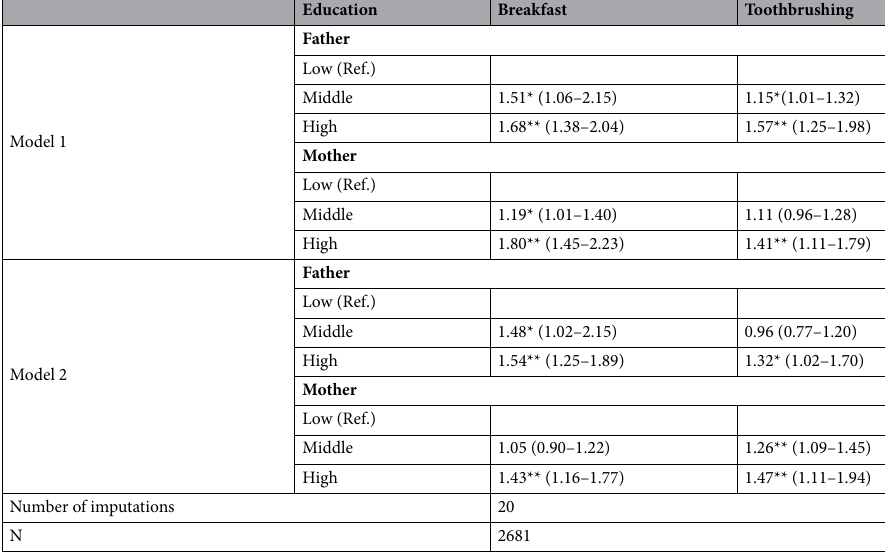
Table 6. Associations between fathers’/mothers’ education and child health behaviours. These results were estimates by multilevel ordered logistic regression, controlling for sex of a child, parental ages, and the scale of a residential area and fitting a three-level model incorporating school type nested within residential areas. The sample was restricted to non-single-parent households. Educational attainment for each parent was included in the Model 1, while both parents’ educational attainments were included in the Model 2. Values are odds ratios and 95% confidence intervals based on robust standard errors in parenthesis with *p < 0.05, **p < 0.01.